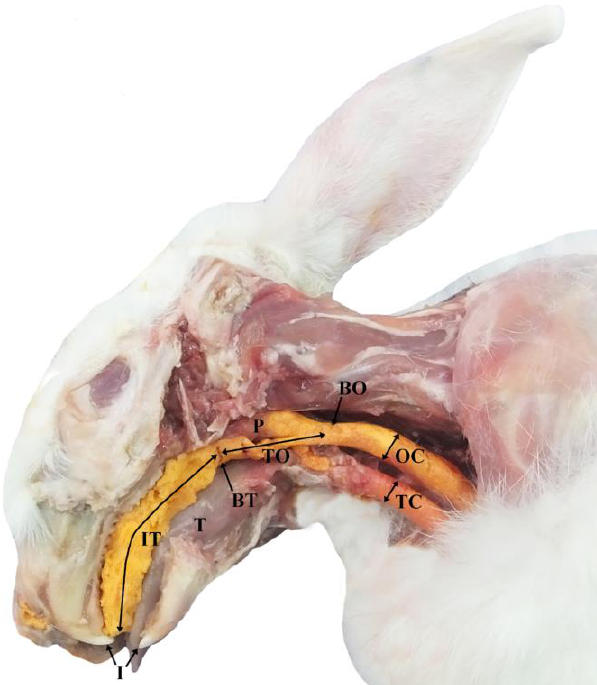
Figure 1. Anatomical preparation of a rabbit head. The anatomical preparation was obtained after the removal of the ramus and the caudal part of the body of the left mandible. The yellow colour indicates the cast of the upper respiratory and digestive tracts obtained by the injection of polyurethane foam. I — incisors; T — tongue; P — pharynx; BO — beginning of the oesophagus; IT — distance